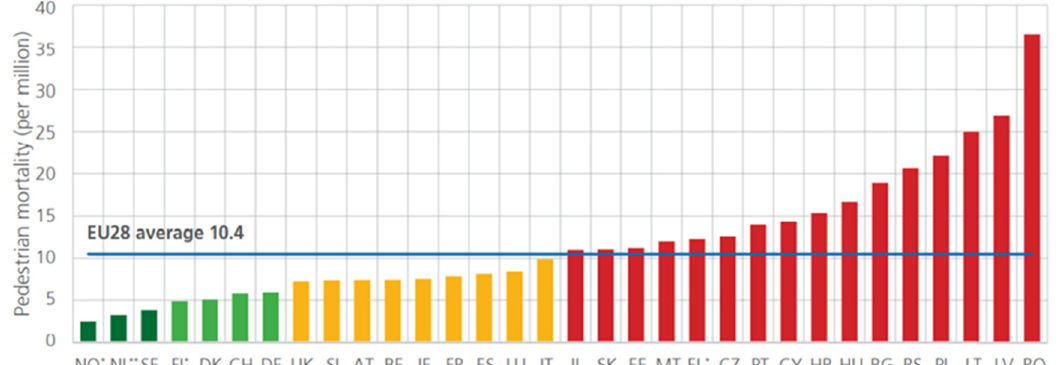
Figure 2: Pedestrian deaths reported by the police ( 2016 – 2018 average ) per million inhabitants. Source: ref. [ 4 ]